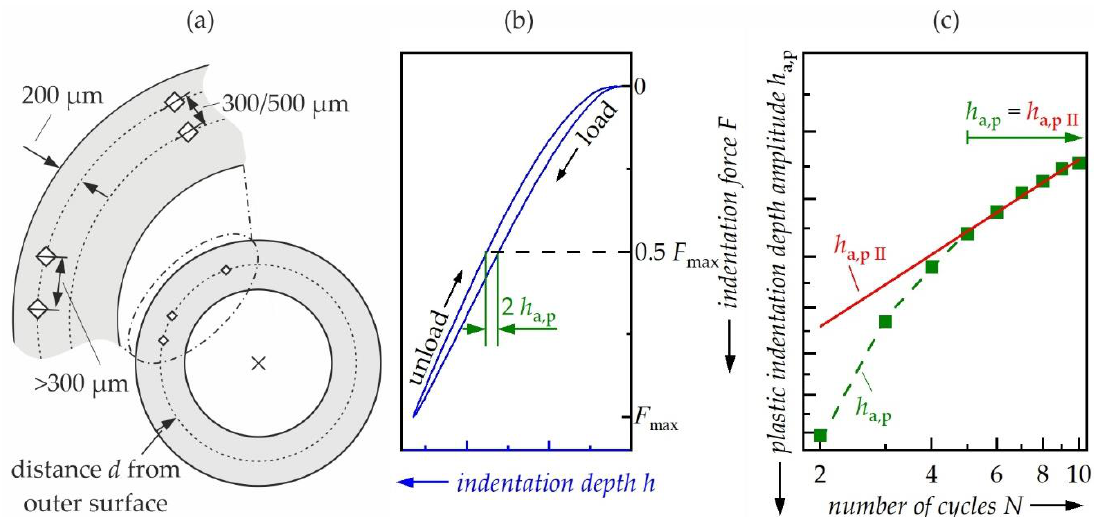
Figure 3. ( a ) Schematics of a cross section of an extruded Al tube with the positions of indentations and the PhyBaL CHT procedure with ( b ) hysteresis of indentation force F and indentation depth h including the definition of the plastic indentation depth amplitude h a,p and ( c ) resulting h a,p – N curve with power function h a,p II [24.]